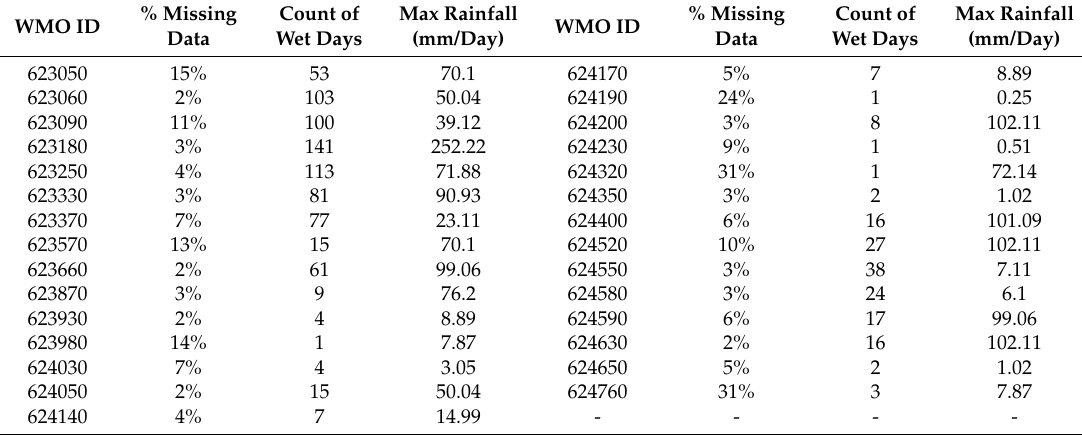
Table 2. The percentage of missing data during March 2014–May 2018, count of wet days, and the maximum amount of recorded daily rainfall at each gauge